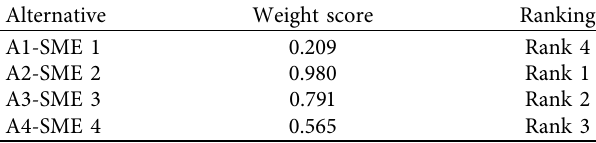
Table 14: Ranking of SME reference on fuzzy-AHP.